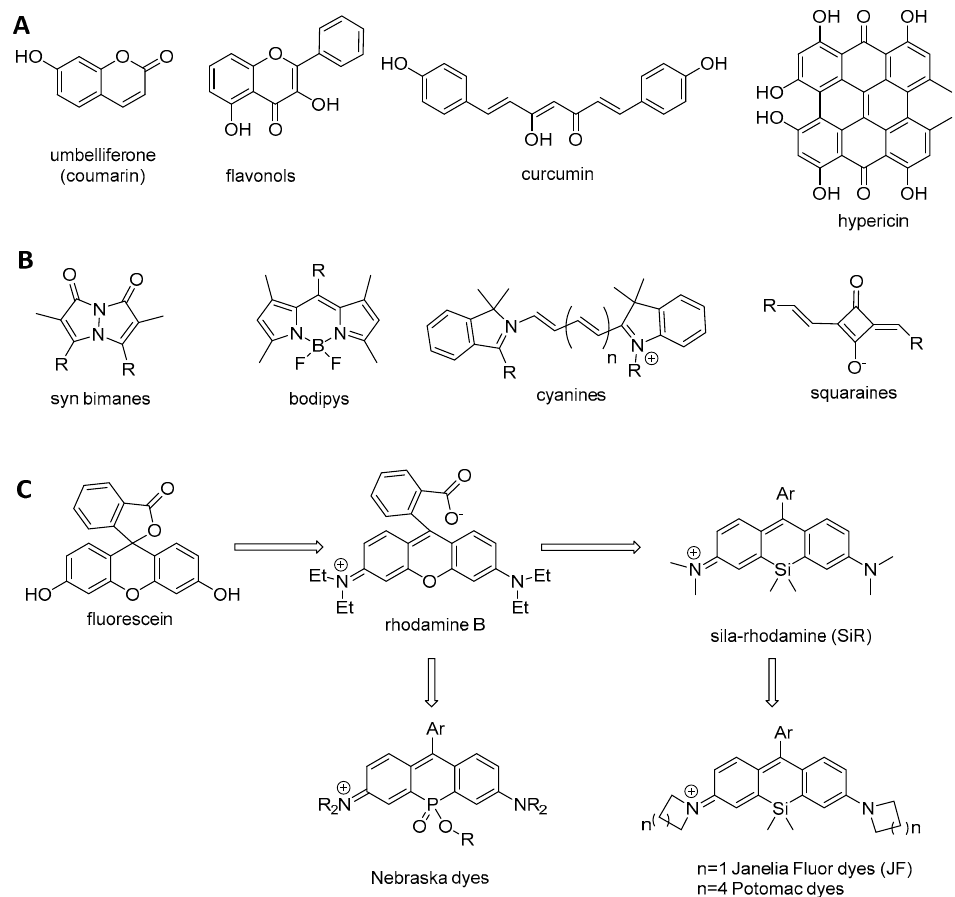
Figure 13. Examples of natural and synthetic fluorescent probes. ( A ) Fluorescent natural products; ( B ) Representative families of fluorophores; ( C ) Synthetic xanthene dyes derived from fluorescein.